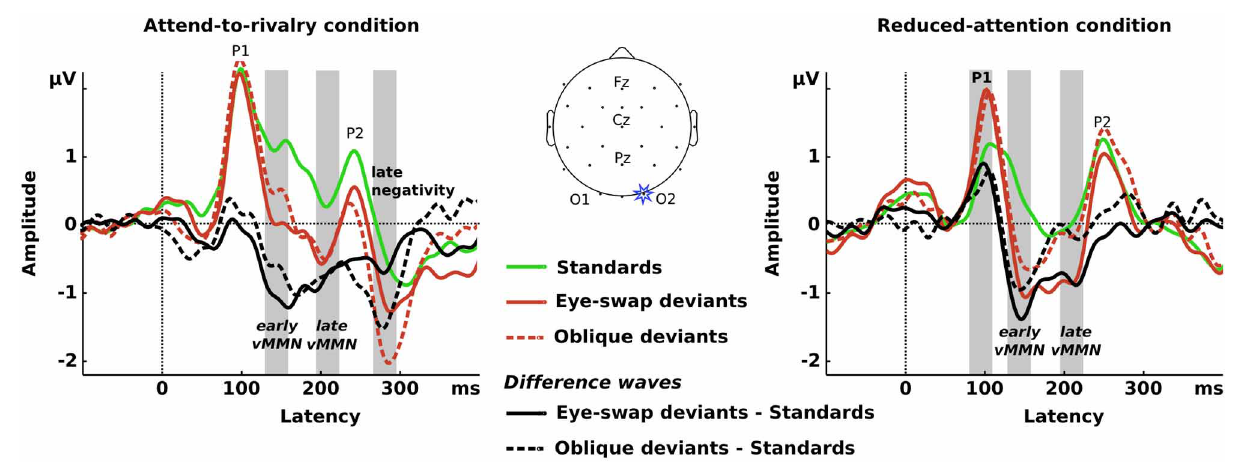
FIGURE 2 | Left panel: ERPs (colored traces) and difference waves (black traces) from electrode O2 for the attend-to-rivalry condition. The gray vertical rectangles show the time windows for which we analysed the data. Center panel: Representation of the electrode array on a schematic head. Right panel: Same as the left panel for the reduced-attention condition. In